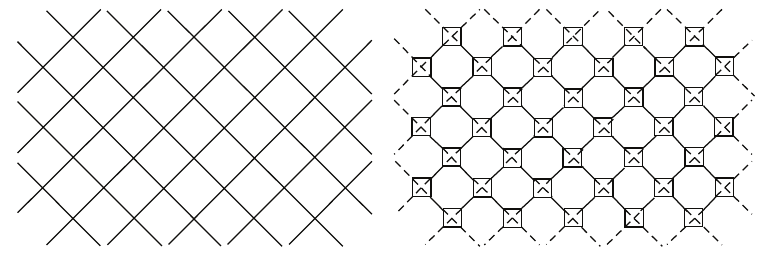
Figure 17: Basic geometry from diagrid.